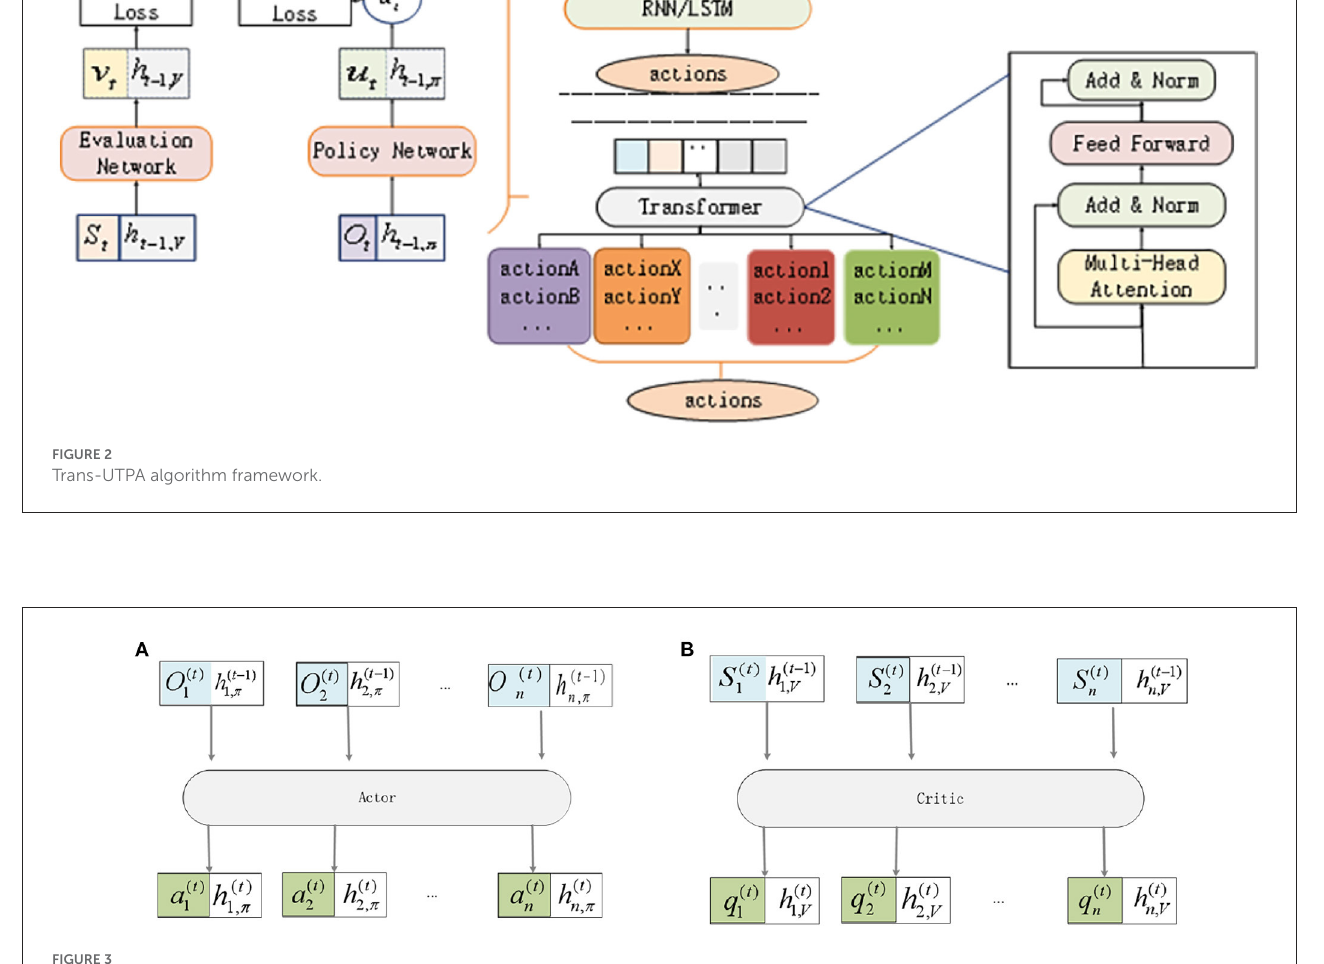
FIGURE3 Embedded representation of observations. (A) This is Actor framework. (B) This is Critic